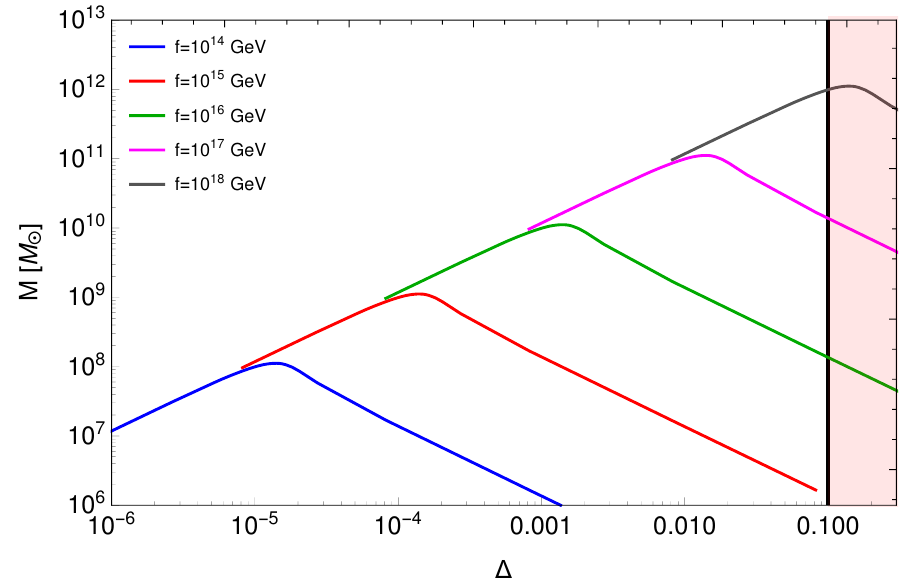
Figure 1 . The allowed masses for condensates of axion particles in FDM, as a function of the bind- ing energy parameter (cid:1); these condensates constitute the cores of FDM halos. Axion condensates in the shaded region are unstable to decay to relativistic axions with a very short lifetime. Here we have used the model parameters m = 10 (cid:0) 22 eV, and f in the range between 10 14 and 10 18 GeV; increasing the particle mass m merely shifts these curves down proportionally to 1 =m